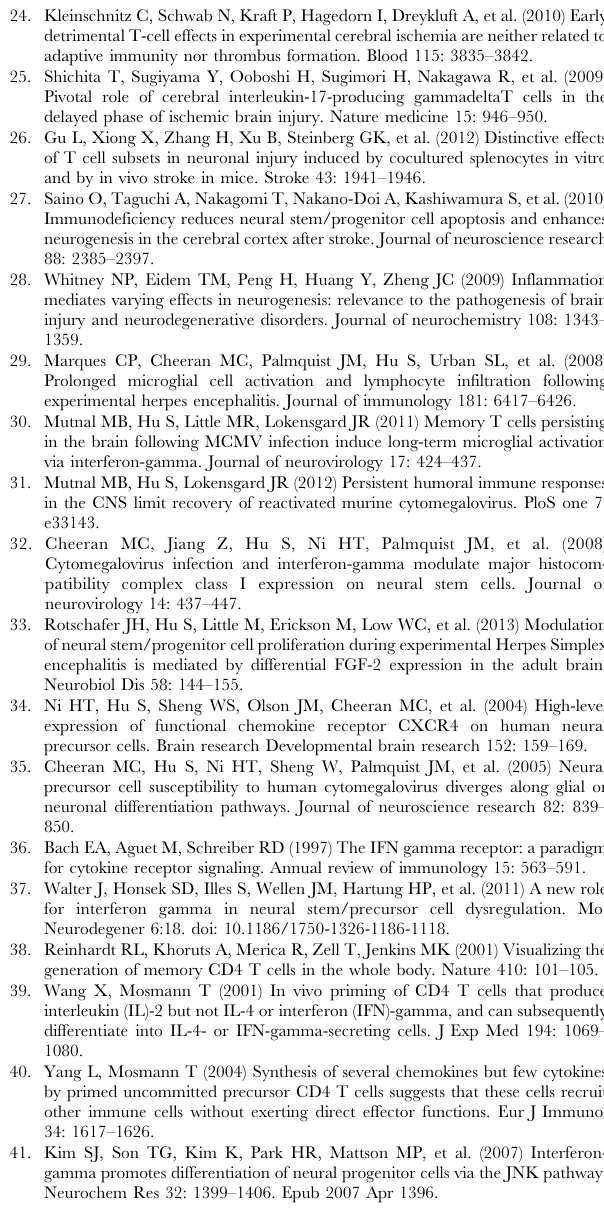
Table S1 IFN- c Production by T